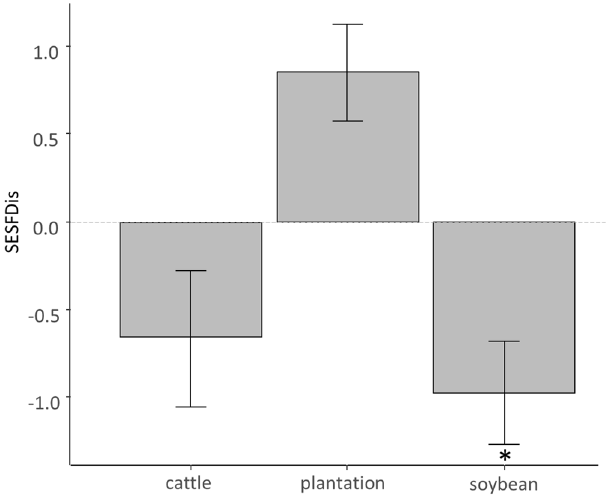
Figure 7. Standardized effect size of FDis index (SESFDis) (mean ± standard error) for different land-use types. SESFDis = 0 indicates the expected value when assemblages follow the null model. Asterisks represent significant departures from 0 obtained by t-tests ( p <